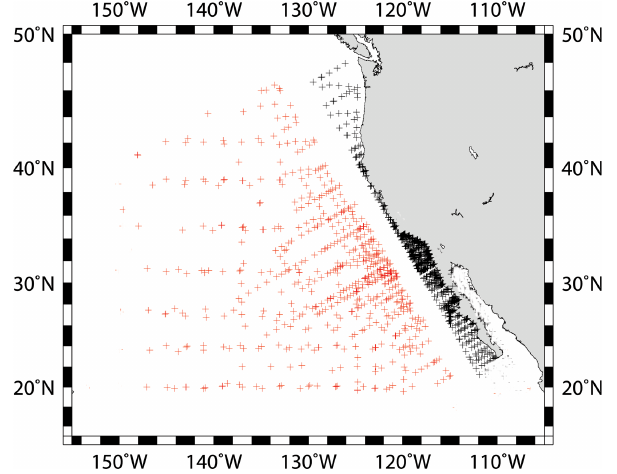
Fig. 3. Linear trends (red line) of meridional wind stress from COADS (Slutz et al., 1985) calculated by the method of least squares. All regions show a significant increase of upwelling. In the Northern Hemisphere a negative slope indicates increase of up- welling. The value of the slope and its 95% confidence interval are given in each panel (in units of 10 − 3 Nm − 2 yr − 1 ). A ∗ indi- cates that the slope is statistically significant at the 0.05 level. Also shown are the unsmoothed time series (thin